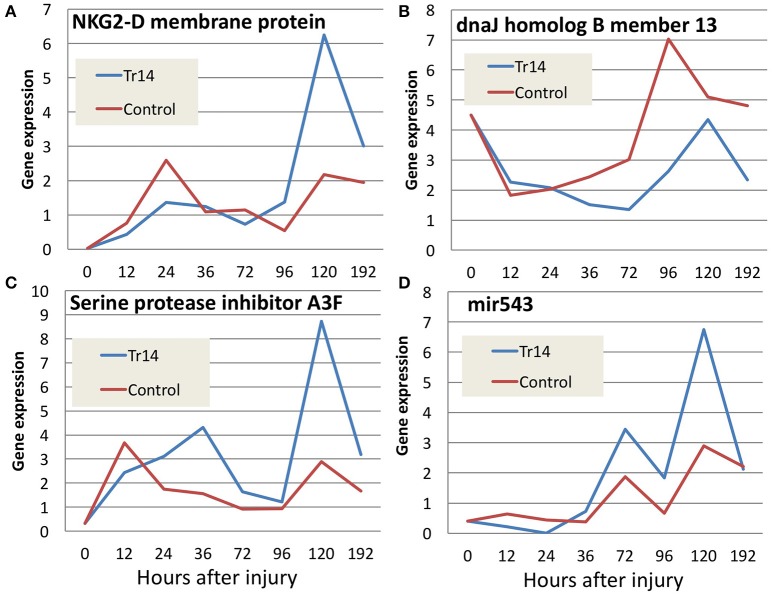
Comparison of gene expression for selected transcripts (A–D) in Tr14 treated animals vs. saline controls. The X axis reports the time after injury to the mouse skin, when the wounded region was harvested for RNA and quantitation by RNA-seq. The Y axis reflects the average normalized gene expression for the transcripts specified in each panel. Red lines indicate expression levels in control mice and blue lines indicate levels in Tr14-treated wounds (IO Group).